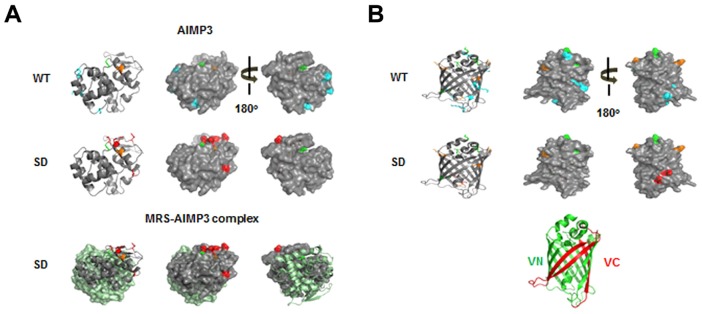
Met-misincorporated residues in Flag-VN–AIMP3 and their location in the AIMP3 and Venus structures. (A,B) The Met-exchanged residues identified by mass spectrometry analysis are depicted in the AIMP3 (pdb2uz8) (A) and the full Venus (pdb3t6h) (B) structures. Residues only identified from HEK293T cells expressing wild-type (WT) MRS (A,B, upper images) and MRS-SD (A,B, middle images) are depicted in cyan and red, respectively. Common residues identified from both cells are represented in orange. The original Met residue in AIMP3 is depicted in green. Mismethionylated residues on AIMP3 in MRS-SD-overexpressing conditions are also represented on the MRS–AIMP3 complex structure (pdb4bl7) (A, lower images). The GST-domain of MRS is shown in light green. Each N-terminus of Venus (VN) and deleted C-terminus of Venus (VC) in the full Venus protein structure is shown in green and red, respectively, for convenience (B, lower panel).